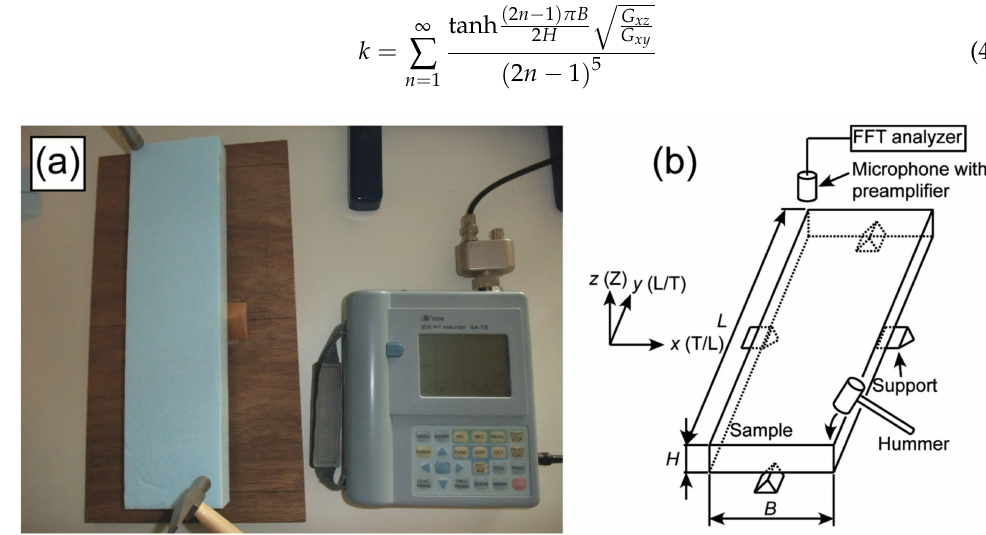
Figure 1. Setup ( a ) and diagram ( b ) of the torsional vibration